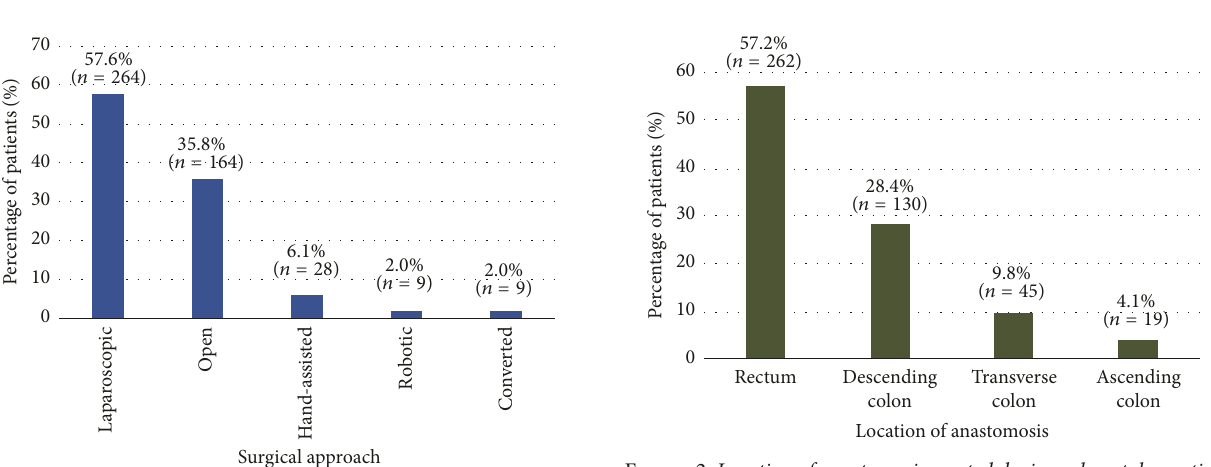
Figure 2: Location of anastomosis created during colorectal resection procedure (overall, 𝑁 = 458 ) . Percentages and absolute numbers of patients with anastomosis in respective location. Further details and by-country data provided in Supplemental Table 4 . “Other” locations documented for 2 further patients (both specified by investigator as sigmoid colon). 𝑁 : total number of patients; 𝑛 : number of patients observed per